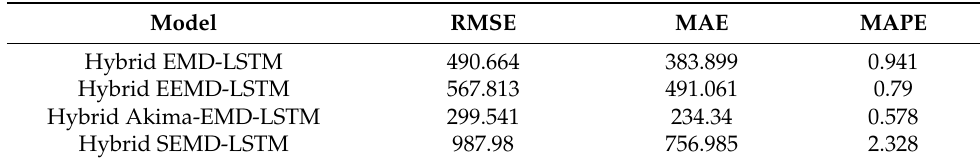
Table 11. Performance metrics of different hybrid models. Model RMSE